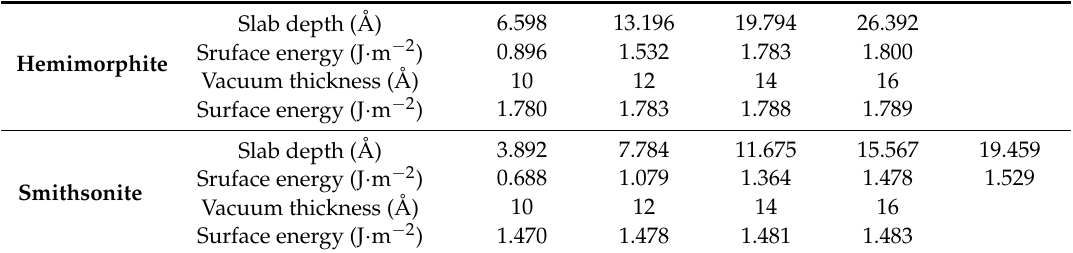
Table 3. Surface energies of hemimorphite (110) plane and smithsonite (101) plane in function of slab depth and vacuum thickness.